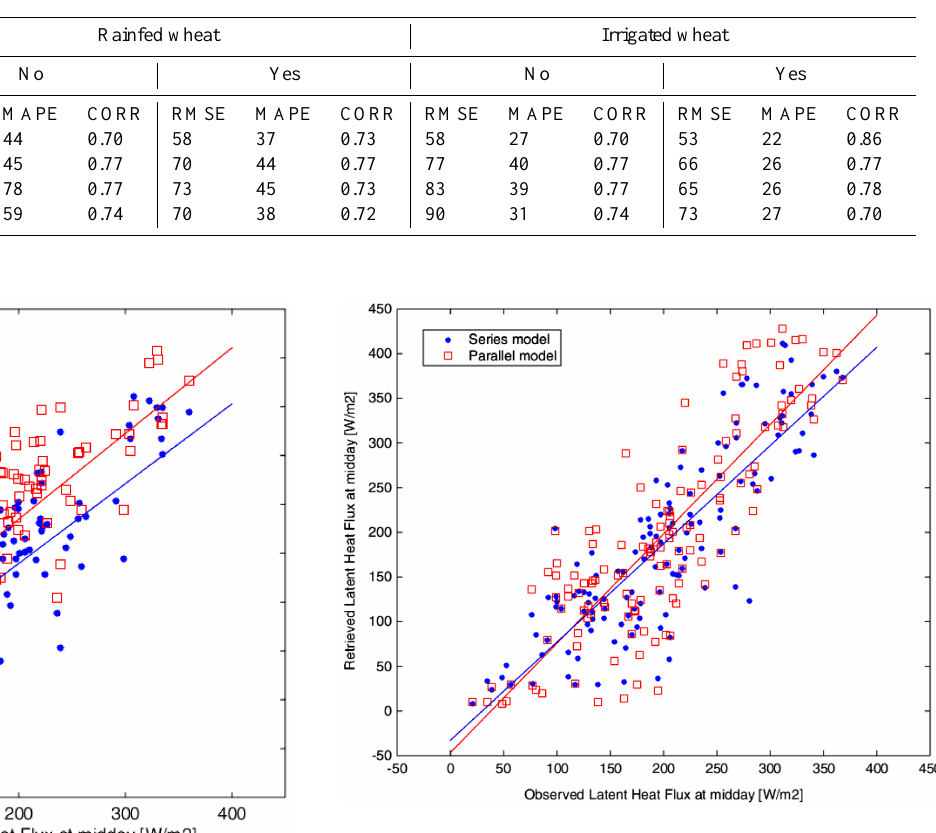
Figure 7. Same as Fig. 6, for the irrigated wheat